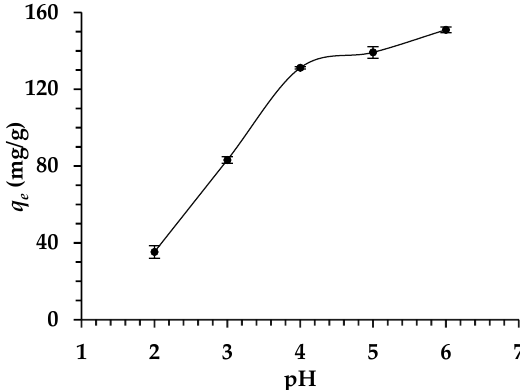
Figure 3. Effect of solution pH on Cu(II) adsorption onto poly(acrylic acid/chestnut shell pigment) (Temperature = 300 K, contact time = 24 h, adsorbent dosage = 1 g/L, initial concentration = 200 mg/L).